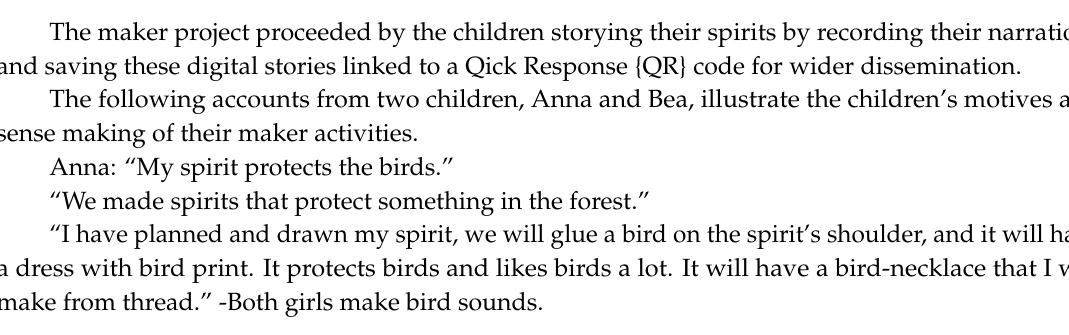
Figure 2. Bea designing, sketching, and making her ‘Spirit of the Trees’.